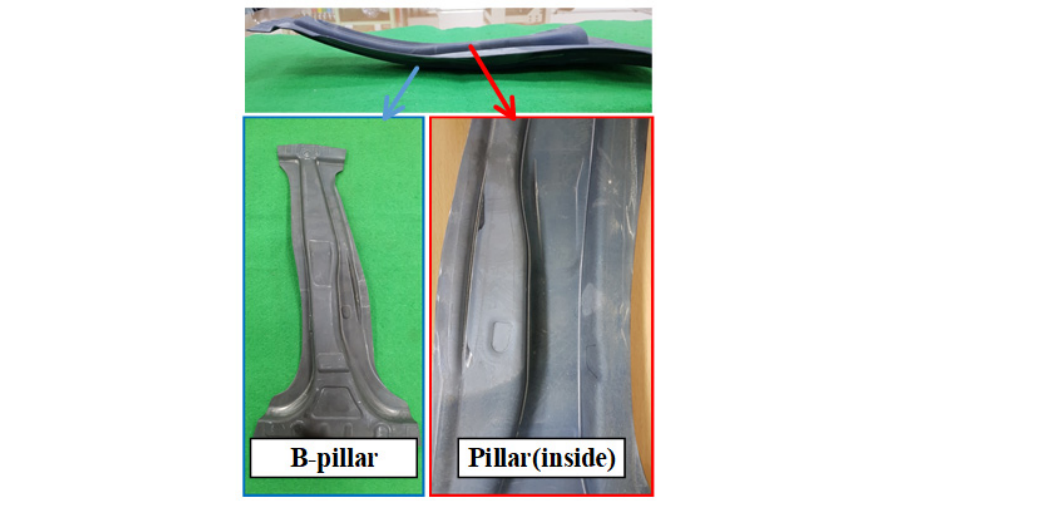
( c ) Figure 11. Comparison of the spring-back between the analytical results and experimental results. ( a ) Cross-section at A. ( b ) Cross-section at B. ( c ) Cross-section at C.